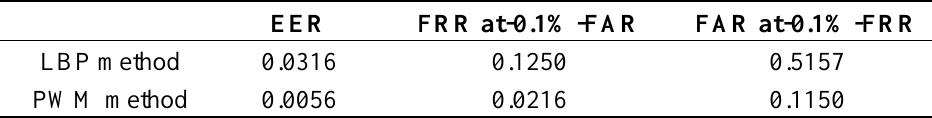
Table 1. Verification performance by different methods.